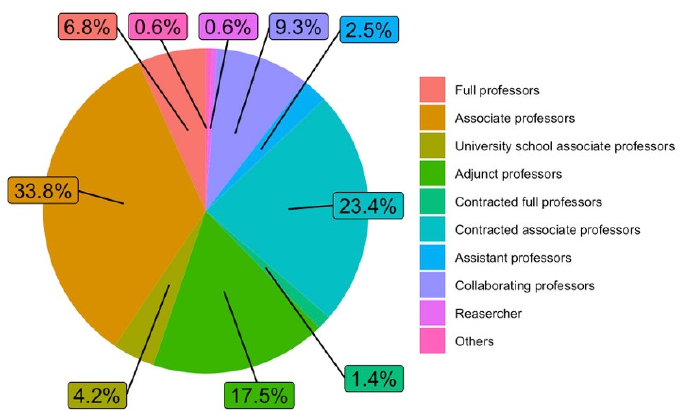
Figure 4. Job categories (answers to Q1.c).